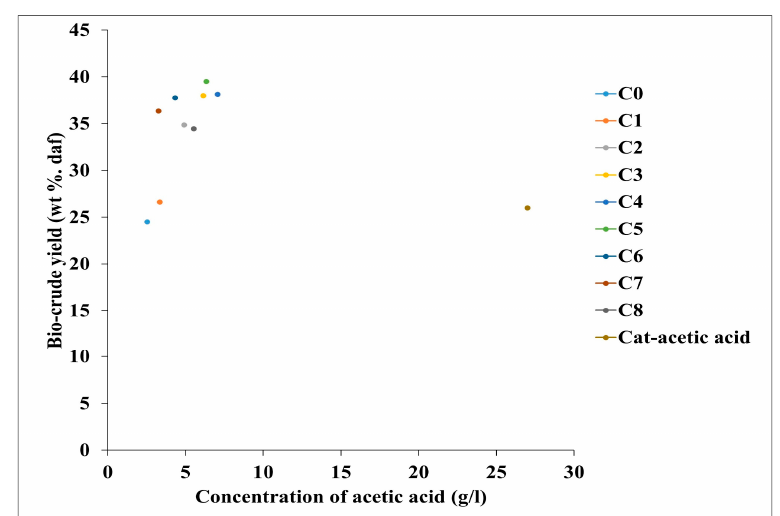
Figure 5. Effect of concentration of acetic acid on bio-crude yield. Figure 5. E ff ect of concentration of acetic acid on bio-crude yield.